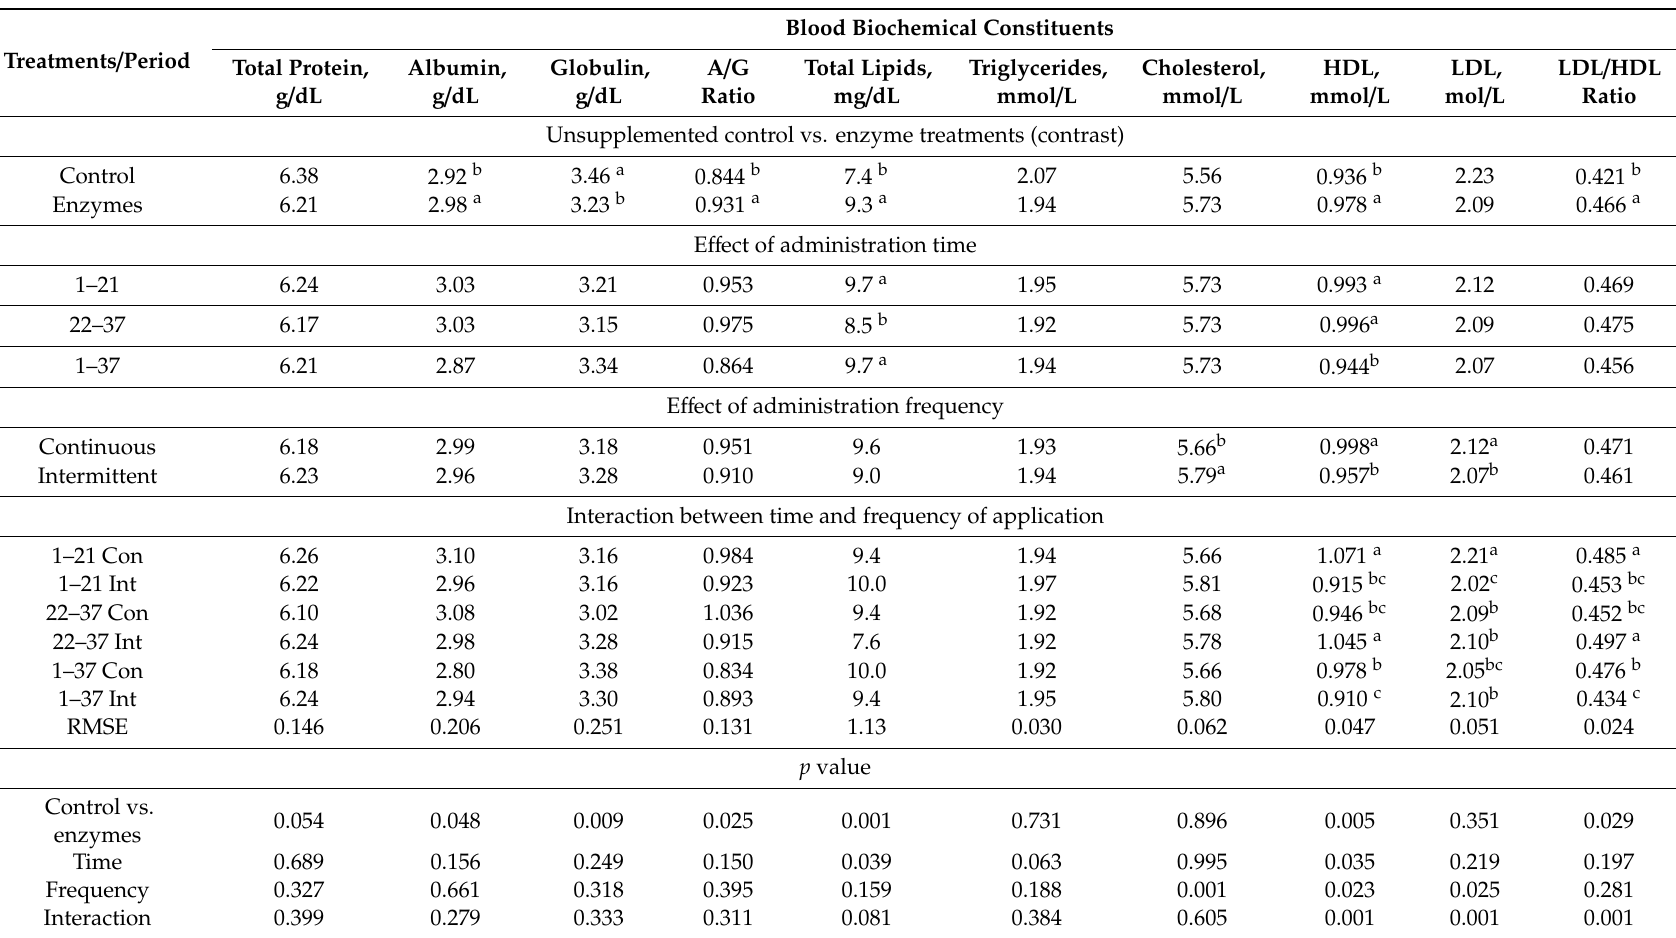
Table 5. E ff ect of multienzymes supplemented in water continuously or intermittently during the starter, grower, and the whole times on blood biochemical constituents of 37-day-old broiler